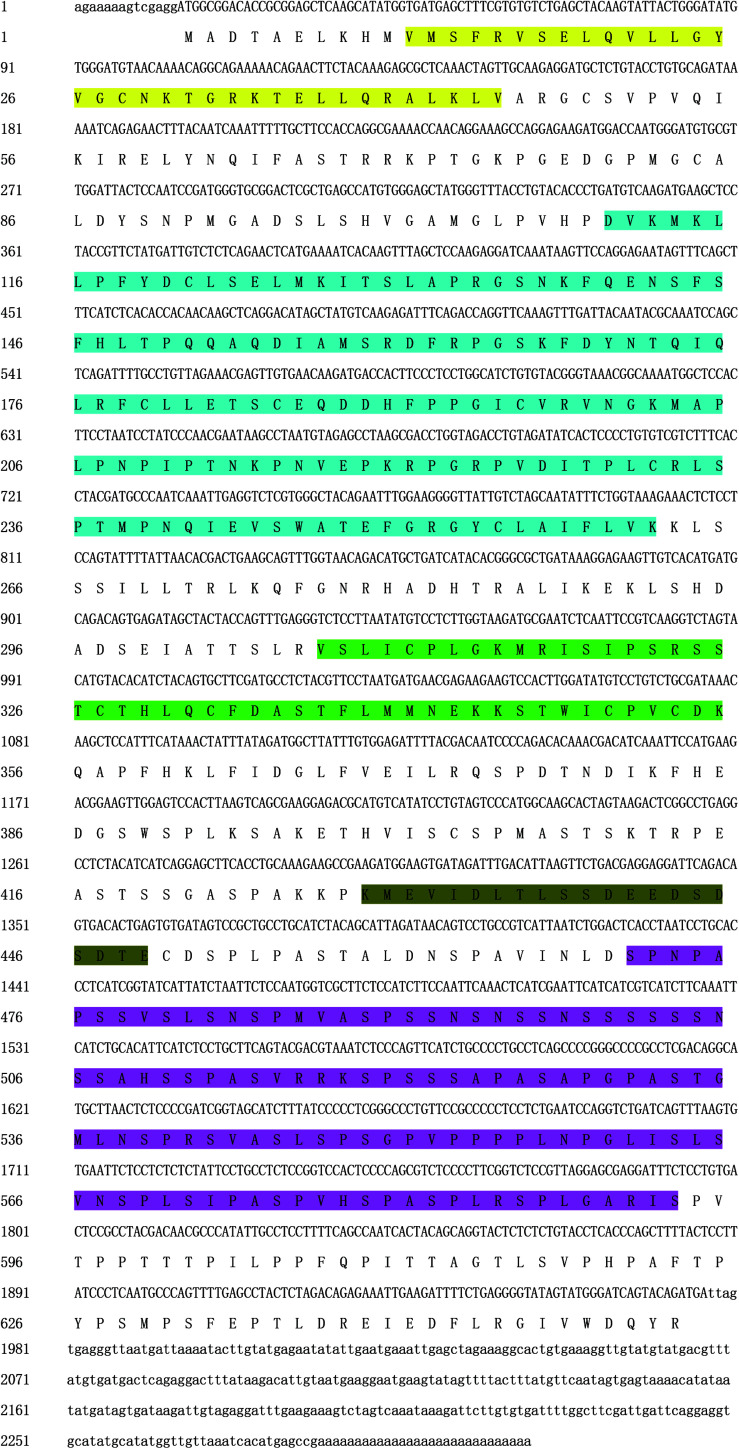
Nucleotide sequence analysis of PmPIAS. 5′UTR and 3′UTR are indicated in small letters. ORF and deduced amino acid sequences are indicated in capital letters. Sequence in yellow, light blue, green, dark green, and purple background represents SAP, PINIT, RLD domain, AD, and S/T-rich region, respectively.